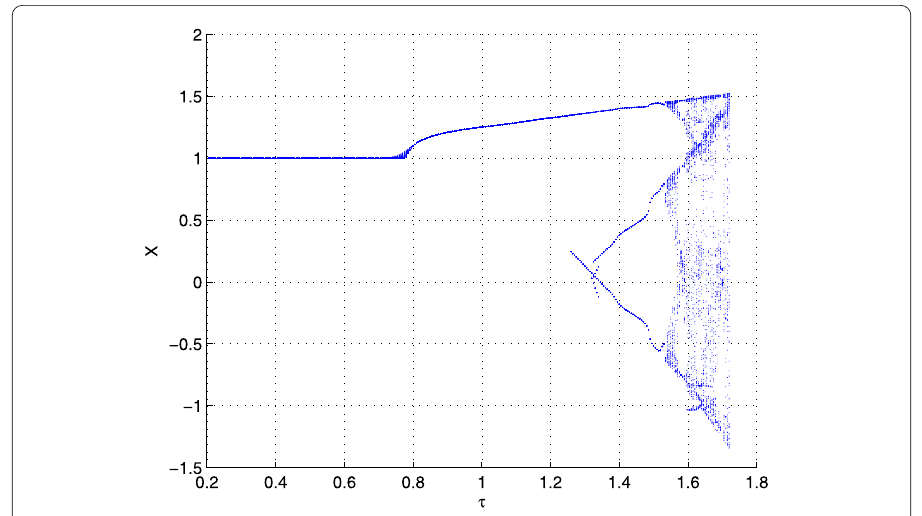
Figure 4 The bifurcation diagram of system (17) with the parameter γ = 1